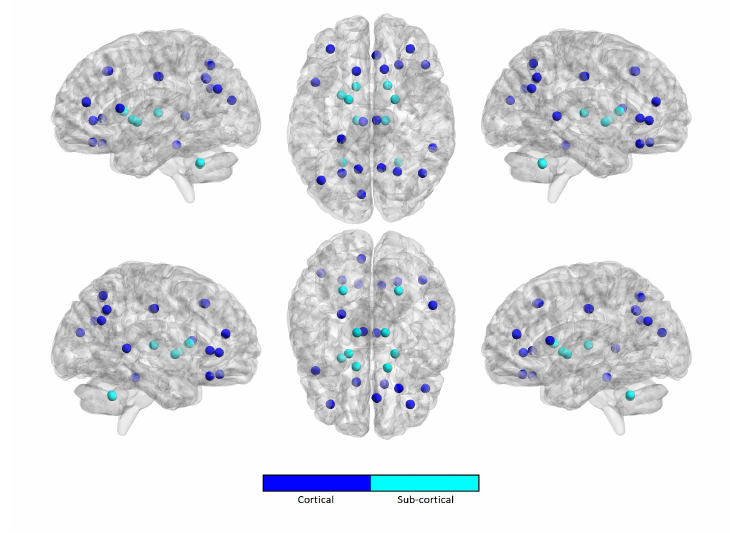
Figure 5. The most significant ROIs for the RF age prediction with no harmonization in NC